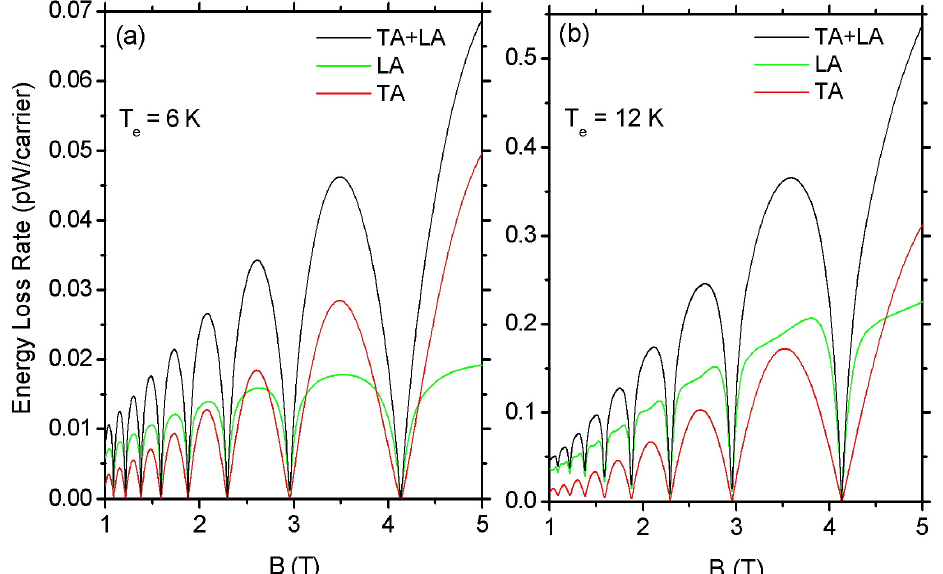
Figure 3. Contribution of TA and LA phonons to the ELR oscillations as a function of B at T e = 6 K ( a ) and 12 K ( b ). The black solid line is the total contribution from both TA and LA phonons. The green and red solid lines show, respectively, the contributions of the LA [see Equation (16)] and TA phonons [see Equation (15)]. The contribution of TA overwhelms that of LA phonons at low T e and high B due to the strong suppression of the latter by screening. ( n s = 10 16 m − 2 and γ = 2 meV/T 1/2